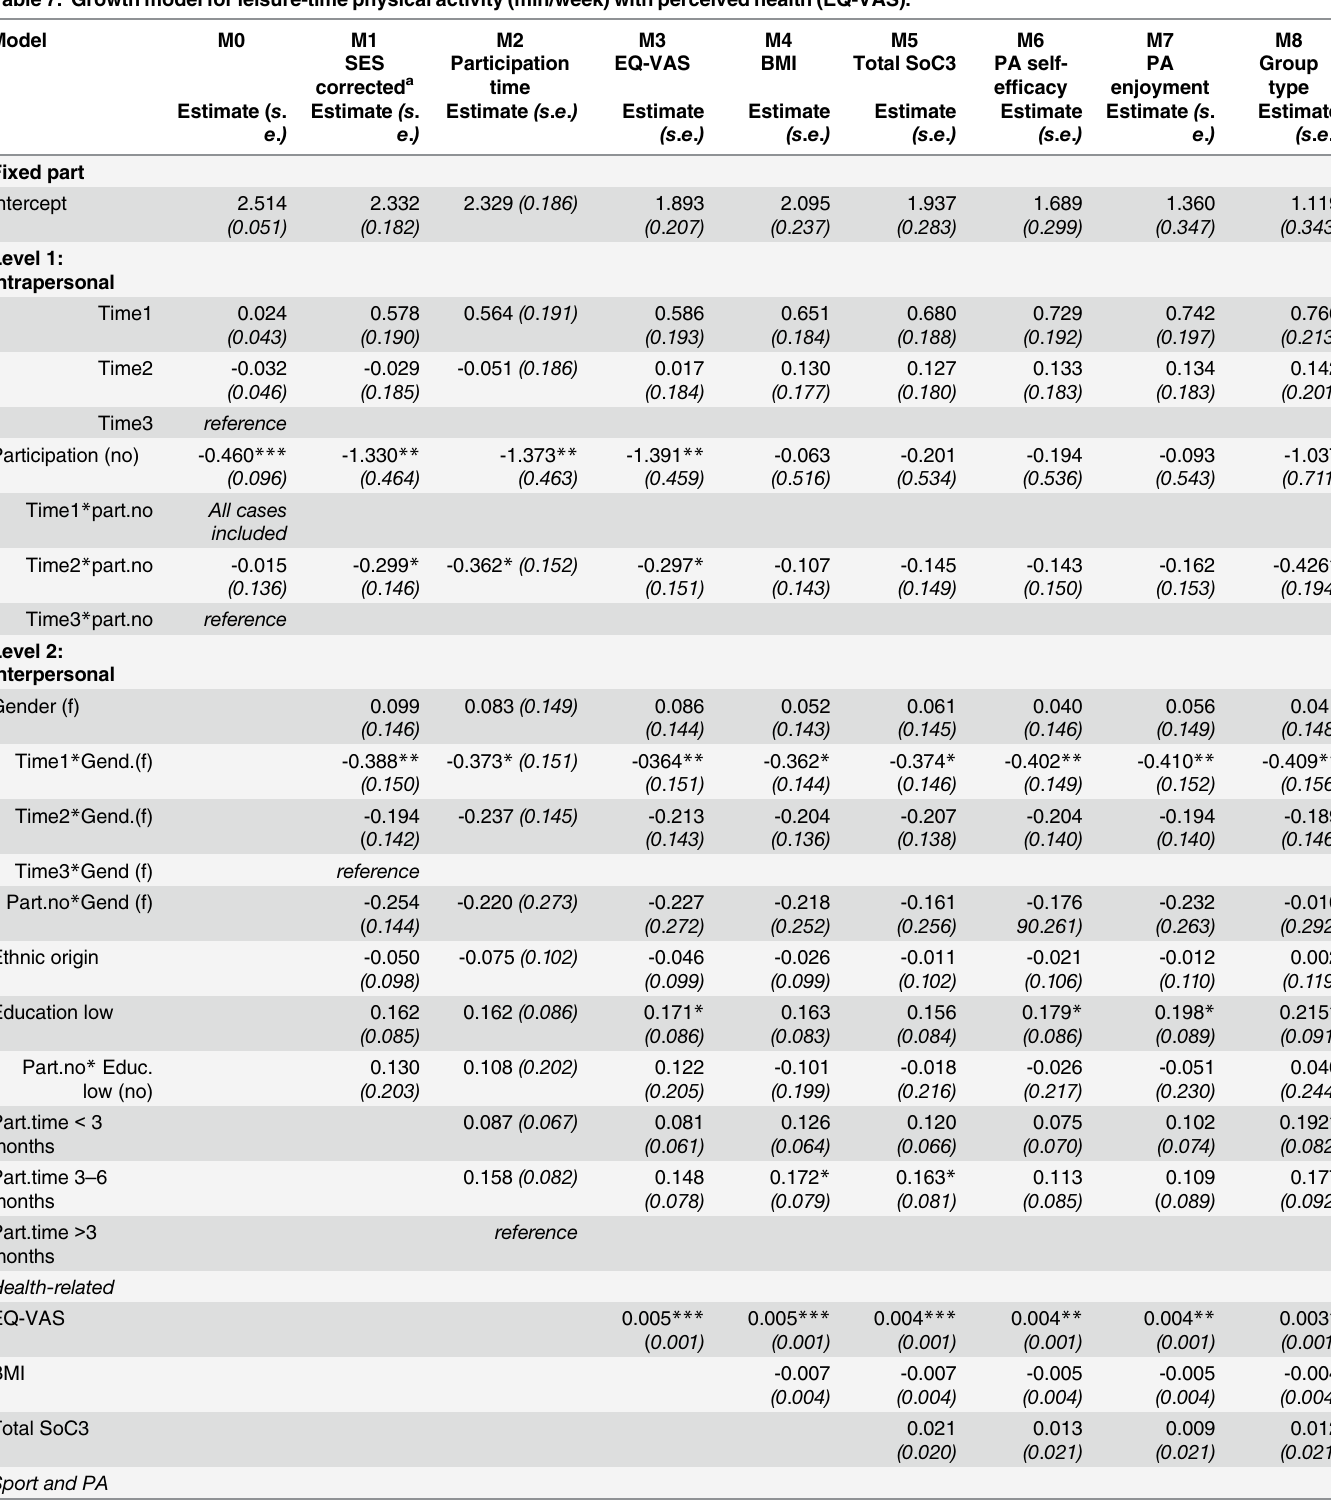
Table 7. Growth model for leisure-time physical activity (min/week) with perceived health